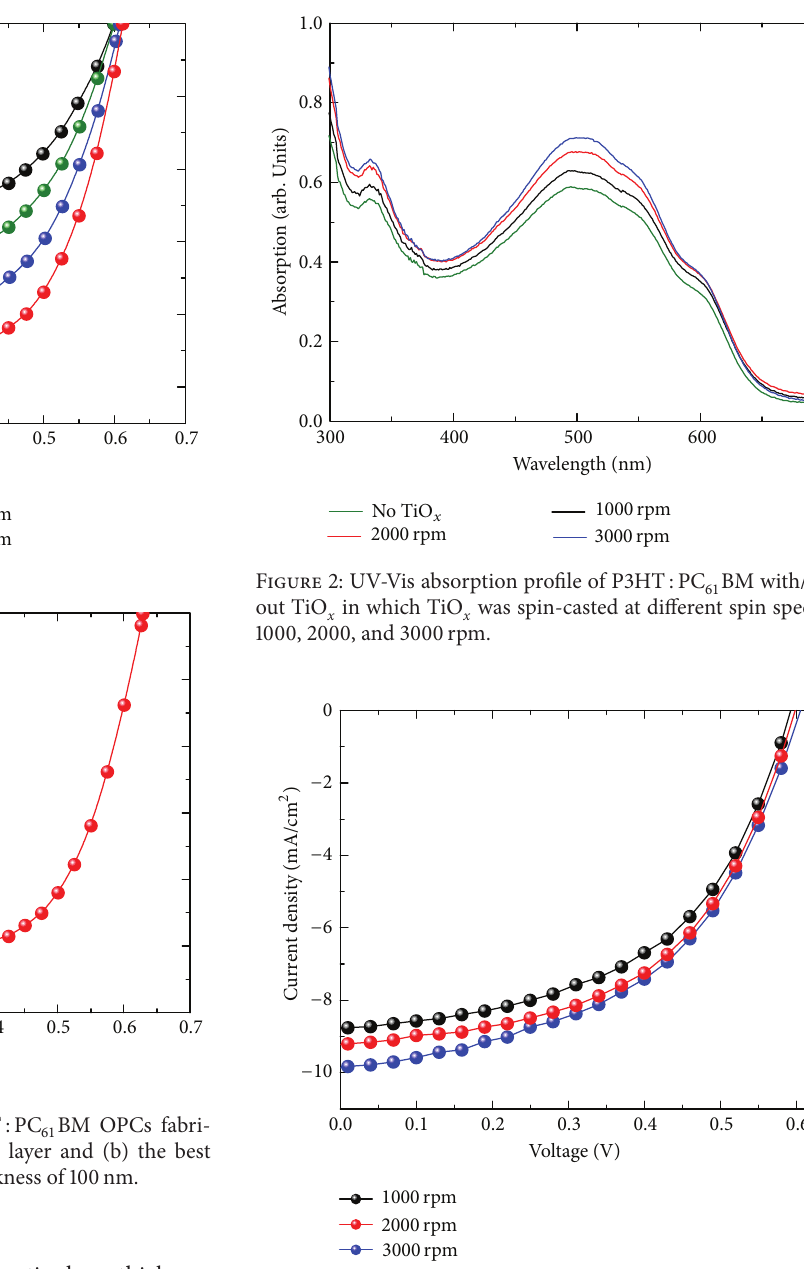
Figure 3: J - V characteristics of P3HT: PC 61 BM OPCs fabricated at different spin speeds of the TiO x